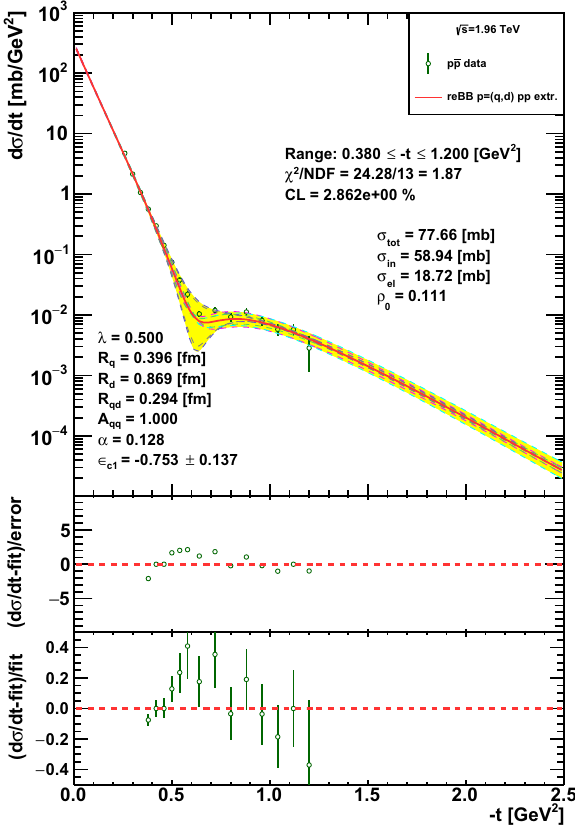
√ Fig. 17 The ReBB model extrapolation for the p ¯ p d σ/ dt at s = 2 . 76 TeV compared to the pp TOTEM d σ/ dt data [9] measured at the same energy. The yellow band is the uncertainty of the extrapolation. The calculated CL value between the extrapolated model and the mea- sured data indicates a significant difference between the pp and p ¯ p differential cross sections, corresponding to a 7.1 σ significance for the t -channel Odderon exchange